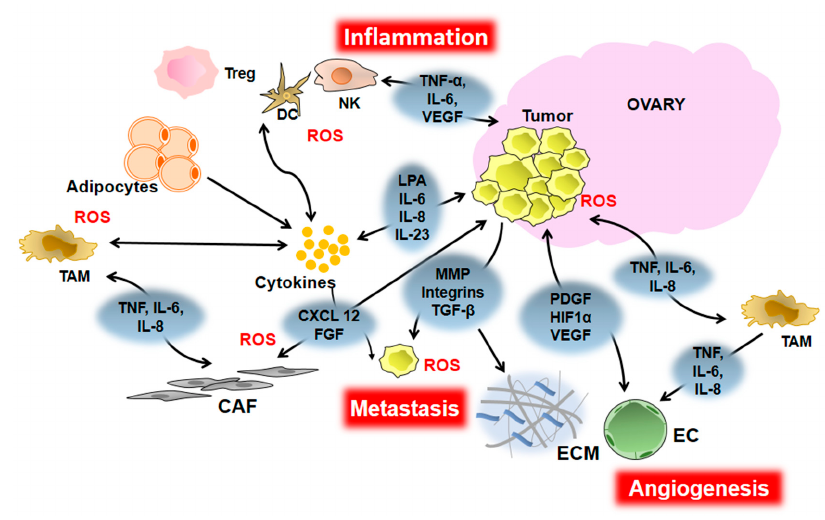
Figure 2. Inflammatory mediators contributing to EOC progression, metastasis, and angiogenesis. EOC cells produce ROS, chemokines, cytokines, and growth factors that can: (1) Lead to recruitment of immune cells like Dentric cells (DC), Natural killer cells (NK), Tumor associated macrophages (TAMs), and T-regulatory (Treg) cells into the TME, which generate additional cytokines, ROS, and growth factors, resulting in chronic inflammation. (2) Stimulate the tumor cells themselves, the TAMs, and the surrounding fibroblasts (also known as cancer associated fibroblasts or CAFs) to proliferate and secrete growth factors like TGF- β and FGF that stimulate production of integrins and Matrix Metalloproteins (MMPs), resulting in migration of the tumor cell via degradation of the extra cellular matrix (ECM). (3) Stimulate endothelial cells (EC) to produce growth factors like PDGF and EGF and factors like VEGF that stimulate angiogenesis. The double arrows indicate that the cells are a source of the factor as well as stimulated by it.